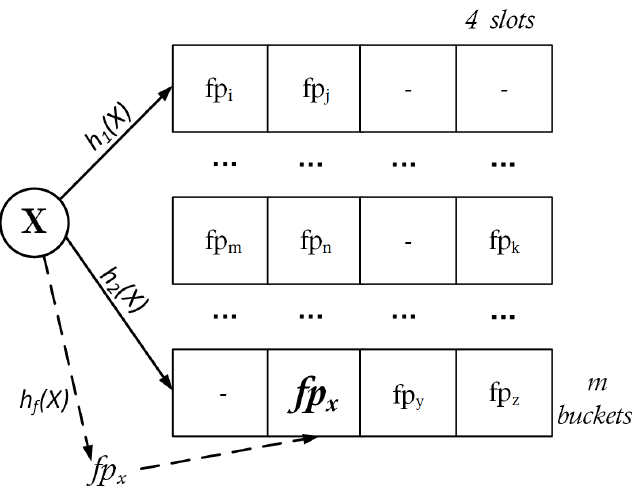
Figure 2. Illustration of a cuckoo filter checking an element